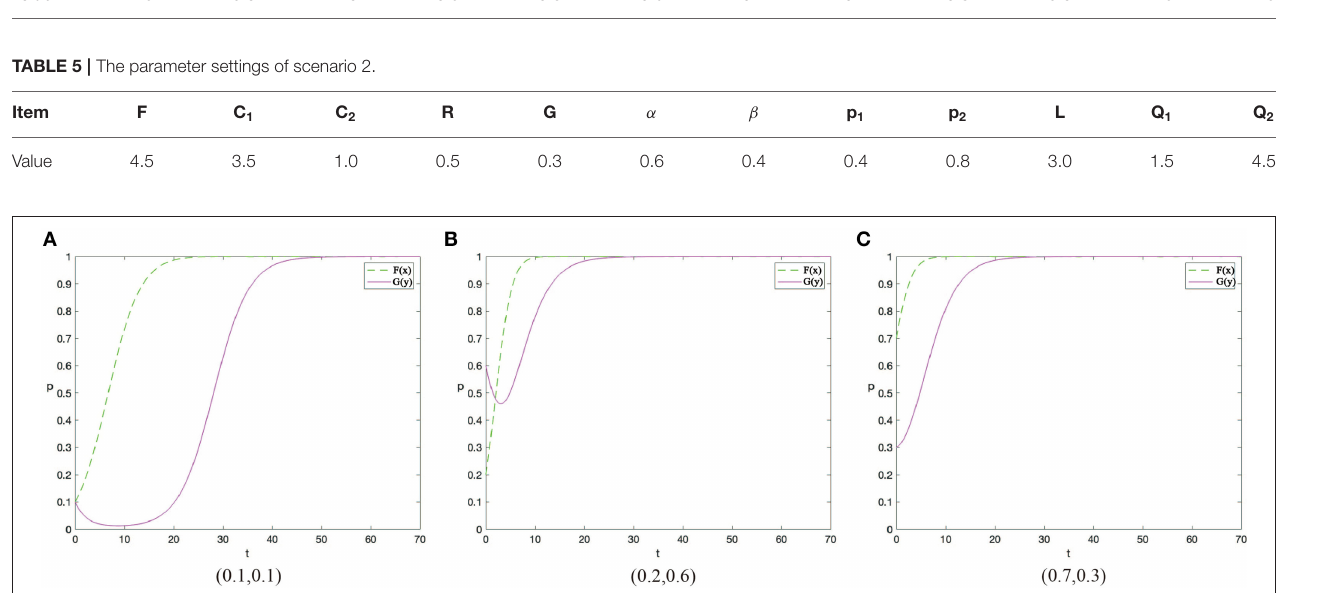
FIGURE 5 | The evolutionary trajectories of (0.1,0.1) (A) , (0.2,0.6) (B) , and (0.7,0.3) (C) in scenario 1.